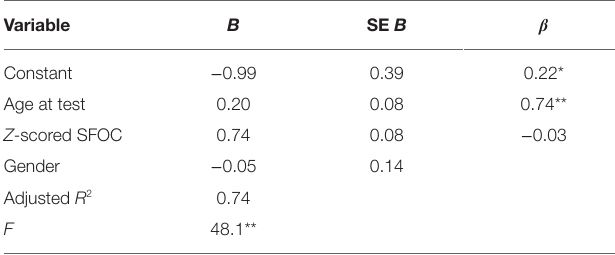
TABLE 2 | Summary of linear regression analysis for three variables (child’s age at test, gender, z -scored SFOC) predicting Spontaneous Focus on Space.